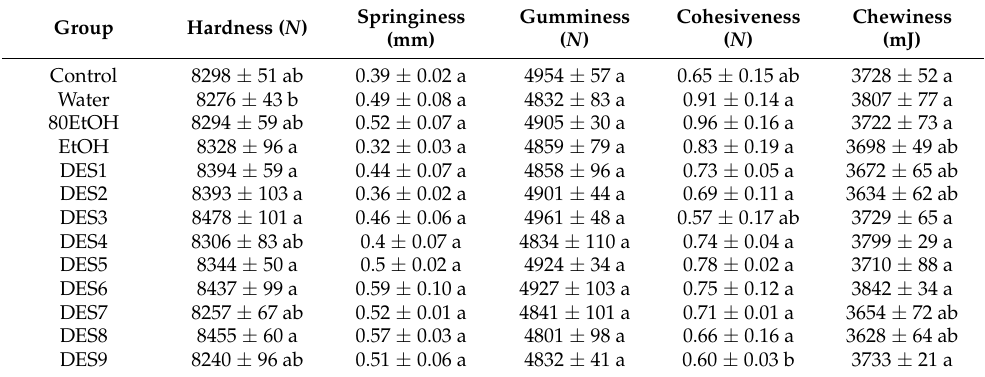
Table 4. Texture characteristics of raw beef and roast beef patties with different ginger extracts. Group Hardness ( N )